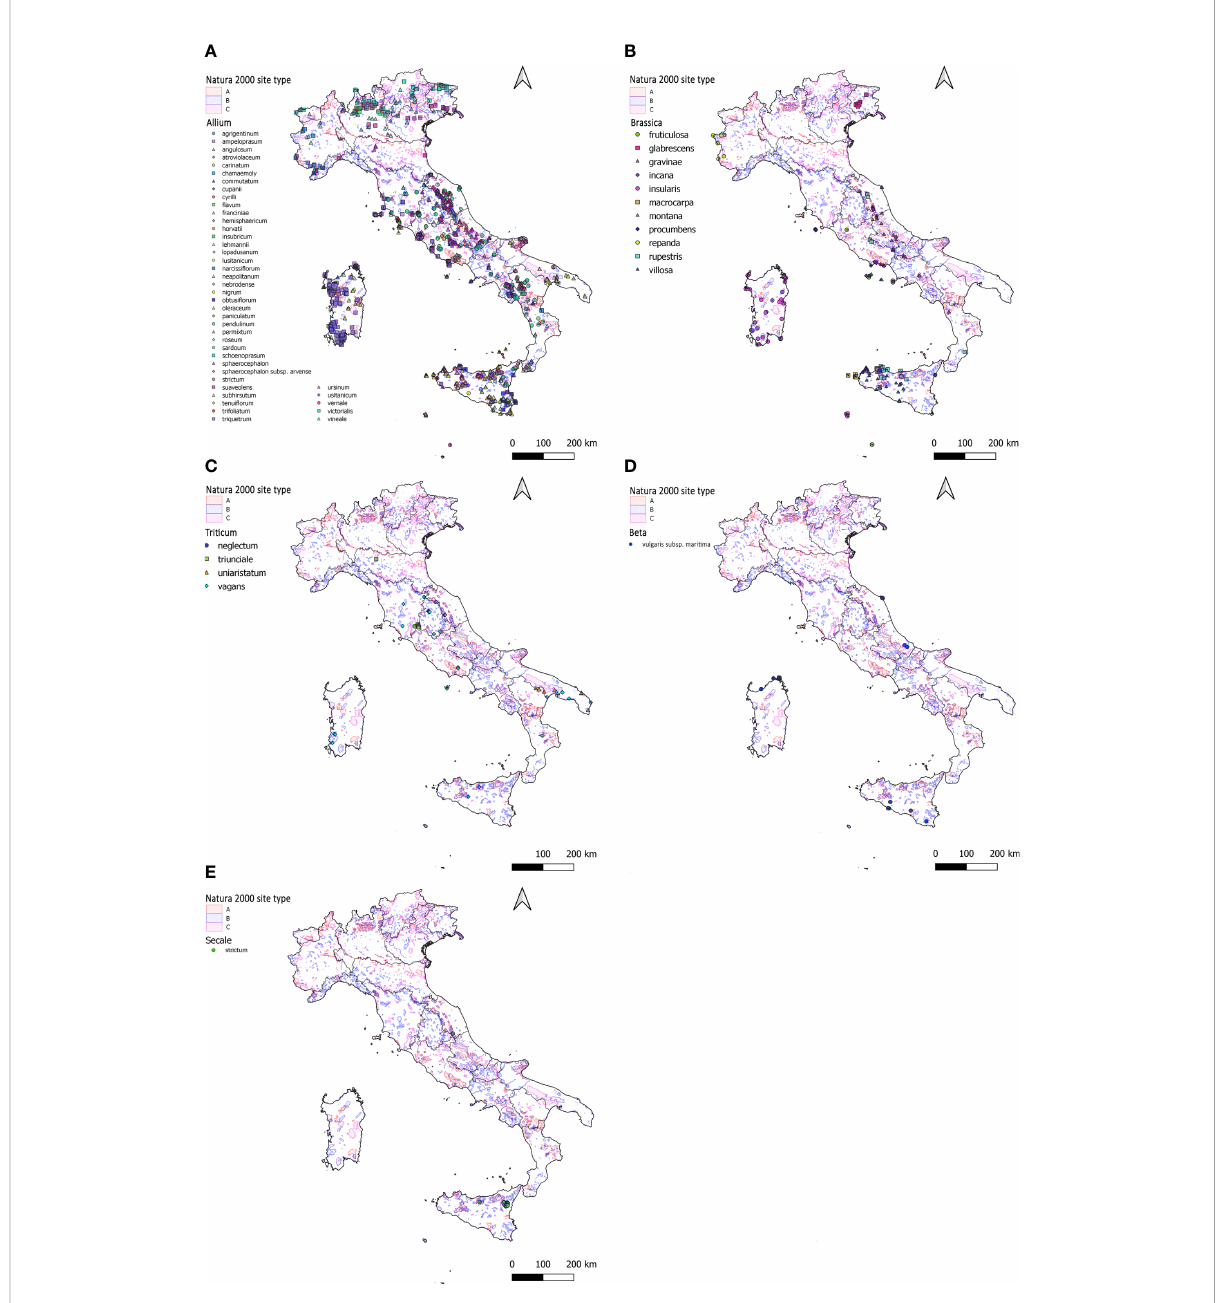
FIGURE 1 Distribution across Italy of the 1,996 populations of the CWR species belonging to Allium (A) , Brassica (B) , Triticum (C) , Beta (D) and Secale (E) as from data available in the Italian National Geoportal. (A – E) species and the different types of Natura 2000 sites are highlighted using different colours as reported in the fi gure legend. Letters associated to the Natura 2000 sites are as follows: “ A ” = designed “ Special Protection Area ” (SPA); “ B ” = “ proposed Sites of Community Importance ” (pSCI), “ Sites of Community Importance ” (SCI) or “ Special Area of Conservation ” (SAC); “ C ” = pSCI/SCI/SAC is the same as designated